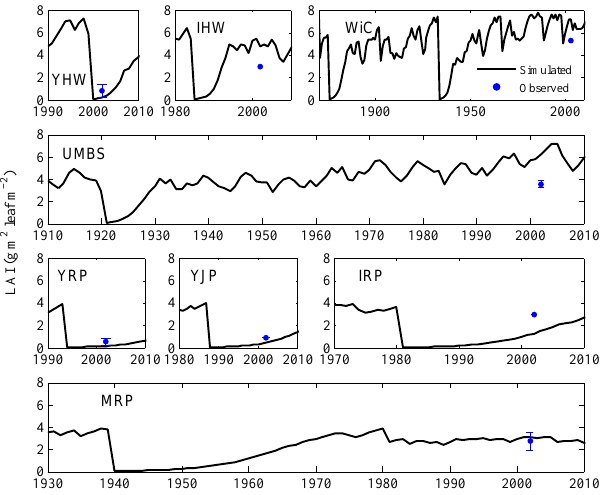
Figure 7. Simulated trajectories of aboveground biomass carbon (AGC) for each site based on the site disturbance history (Table 1). The time series started from the earliest major disturbance for each site. Symbols represent estimated